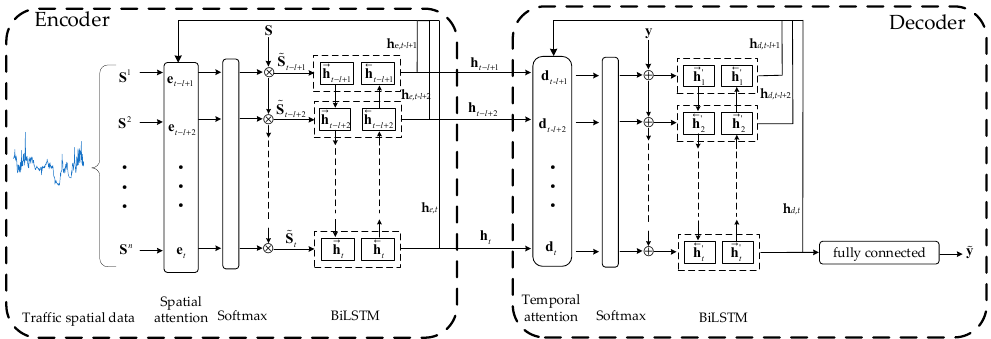
Figure 2. Graphic illustration of temporal clustering and hierarchical attention (TCHA).